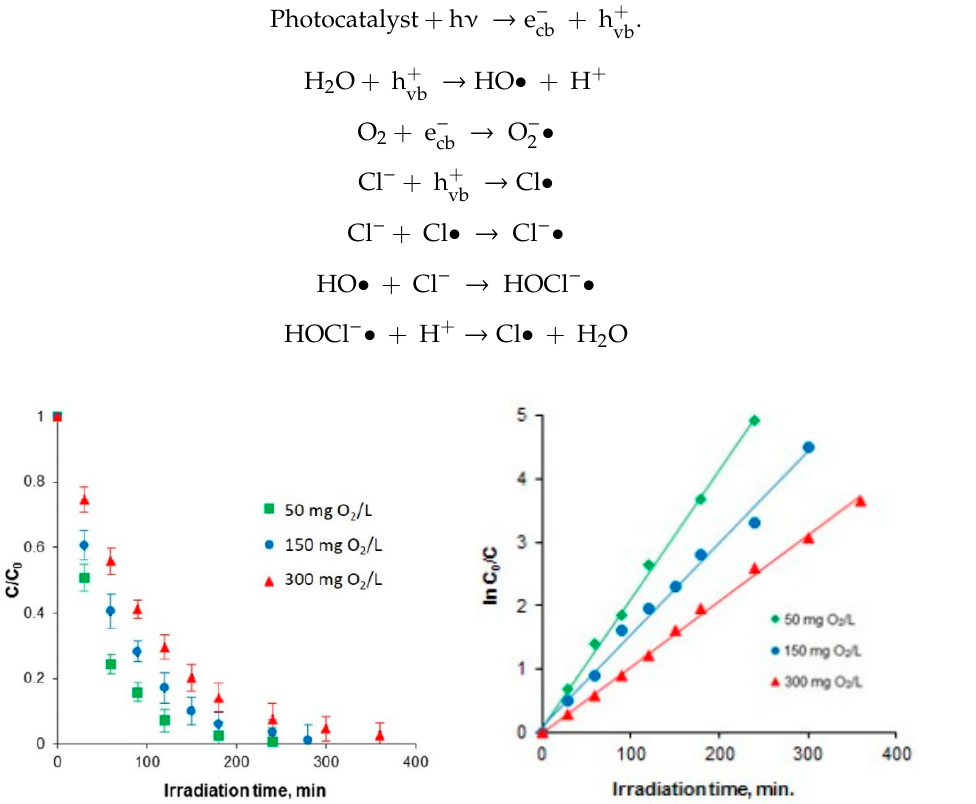
Figure 1. Kinetics of 4-chlorophenol photocatalytic degradation as a function of its initial concentration. Error bars represent the calculated standard deviation for the experimental data.